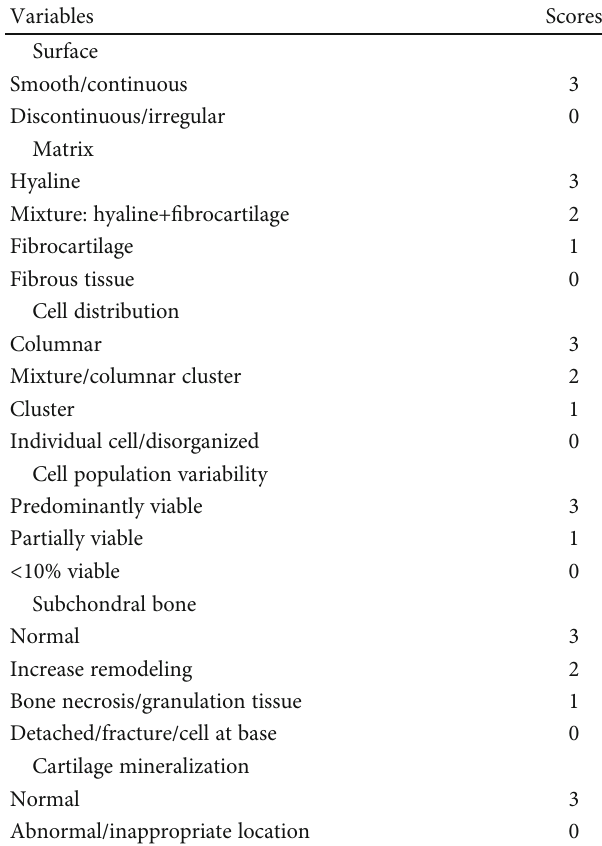
Table 2: Histopathological grading using international cartilage repair society (ICRS) histological